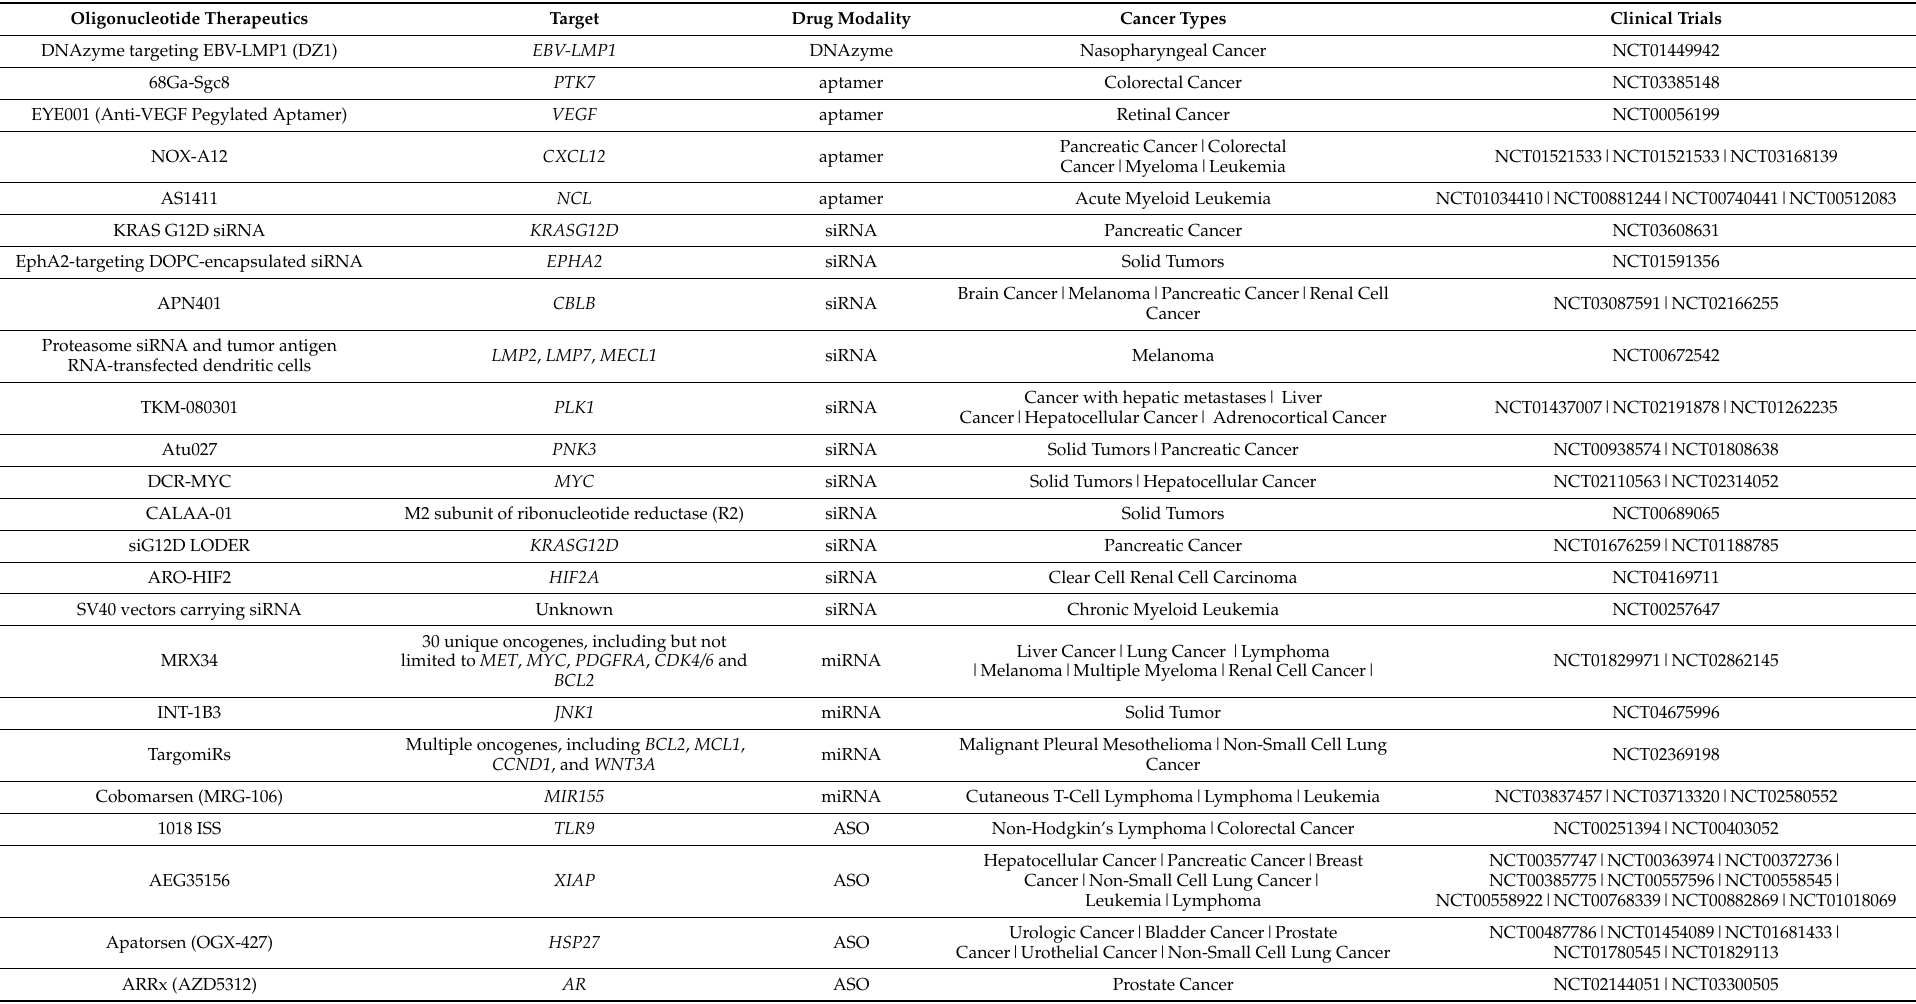
Table 2. Summary of current oligonucleotide therapeutics in clinical trials for